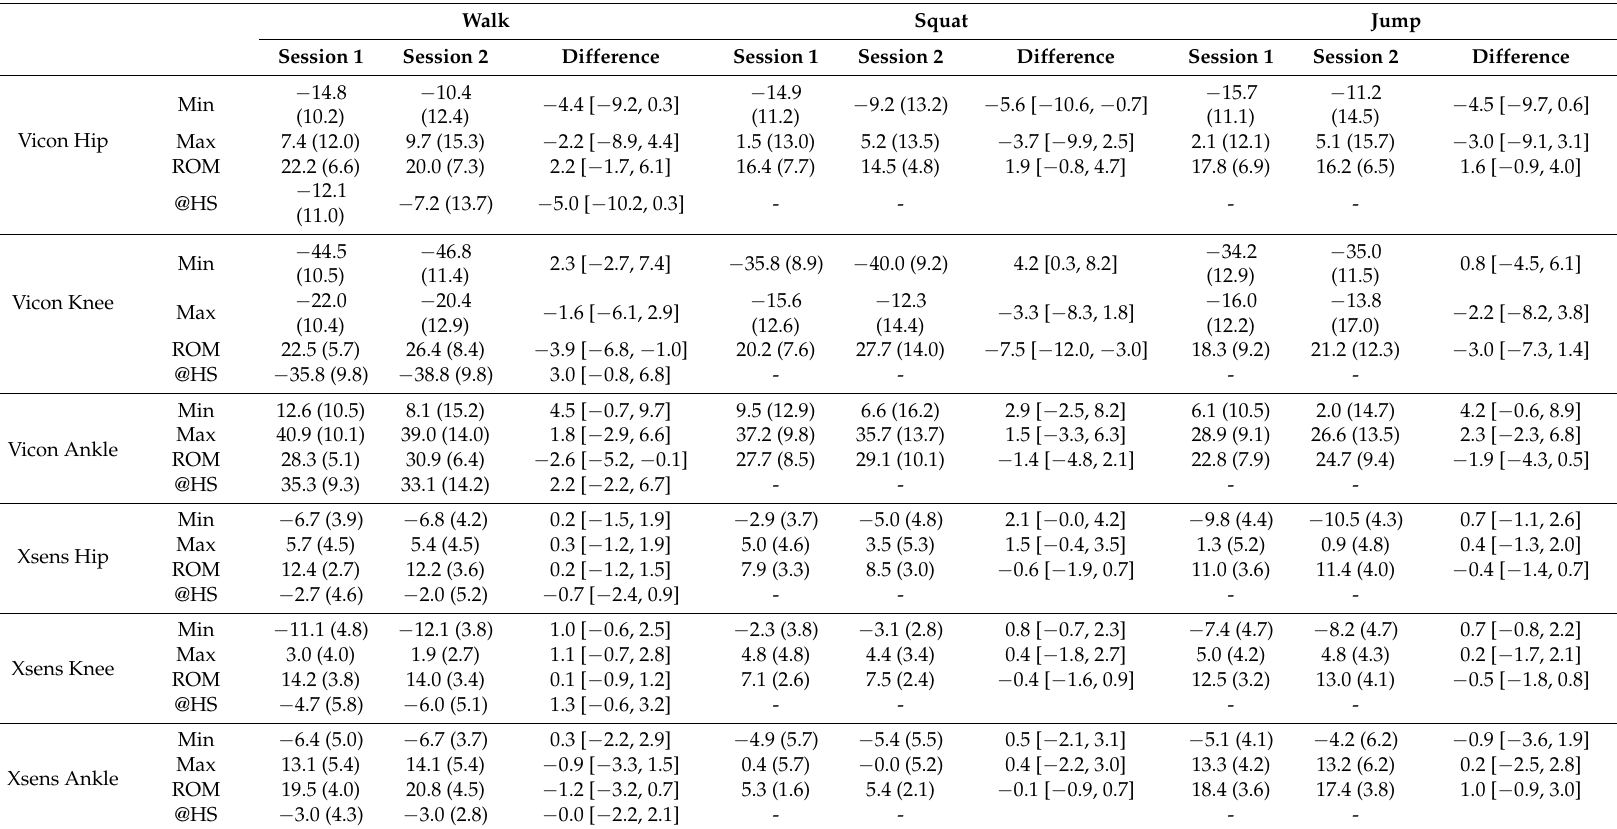
Data for each session are mean (standard deviation). Data for the difference are difference [95% confidence